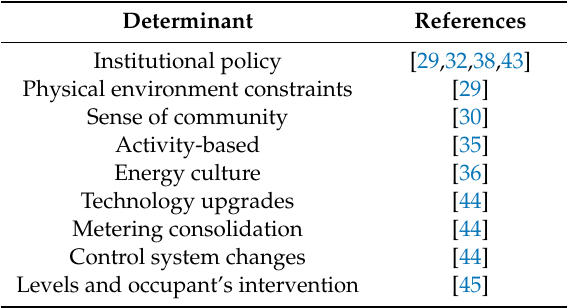
Table 5. Contextual determinants in